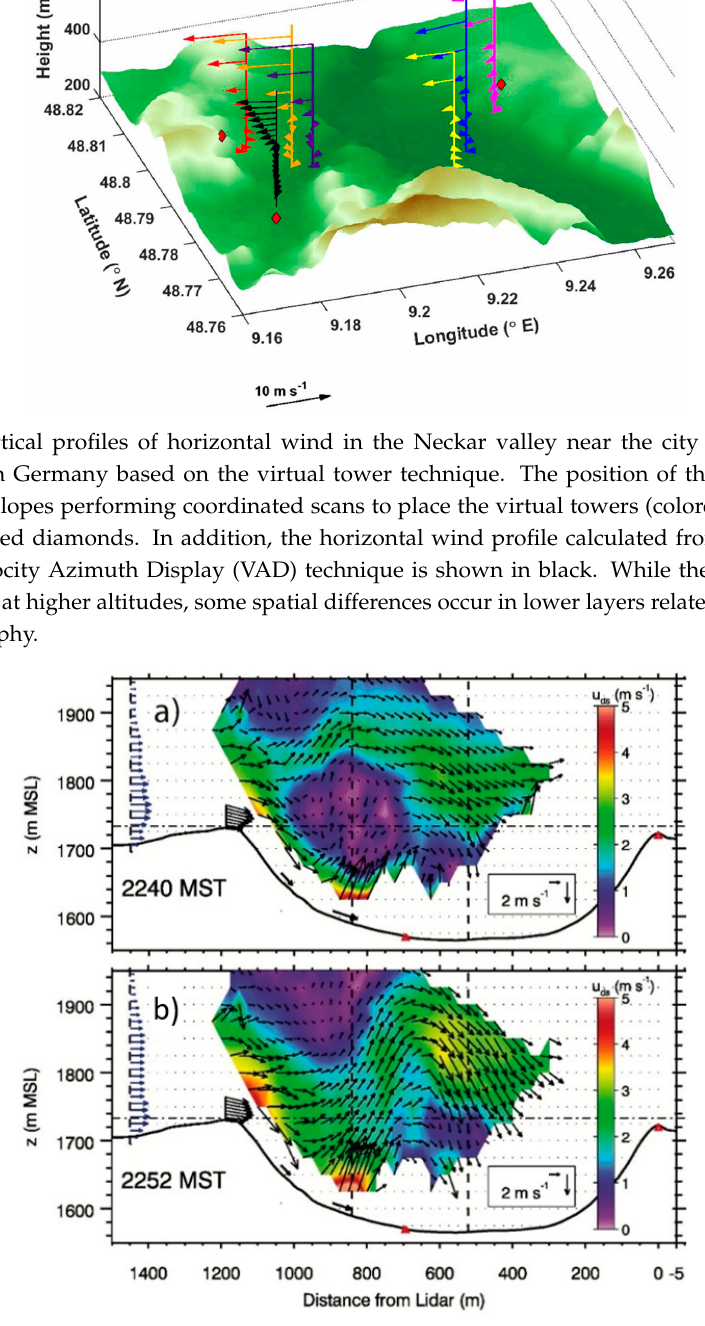
Figure 8. Illustration of an abrupt change in flow structure between the bifurcation and warm air intrusion phases from 2.5-min-mean dual-Doppler wind retrievals at ( a ) 2240 and ( b ) 2252 Mountain Standard Time (MST). The positions of the two Doppler lidar (crater floor and on the rim), which were used for the dual-Doppler retrieval, are indicated by red dots (from [124], ©American Meteorological Society. Used with permission).